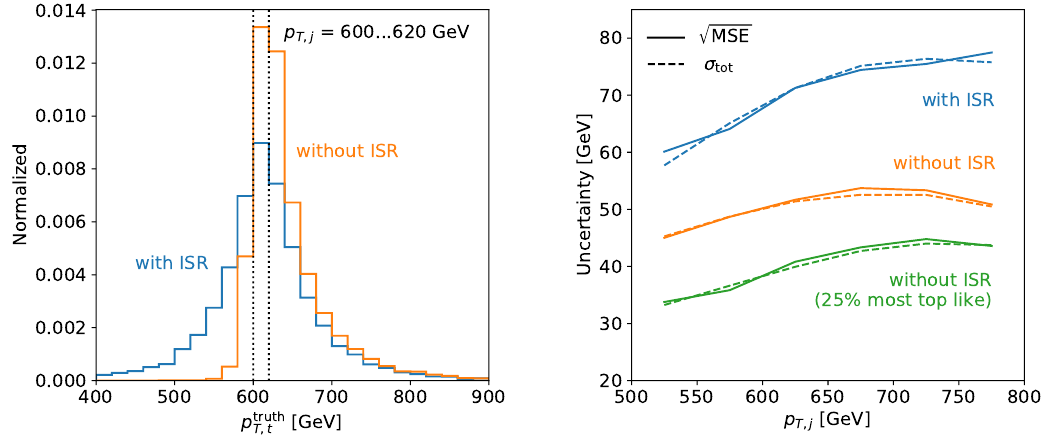
= 600 ... 620 GeV, for jets with p T , j T , t as the network output (dashed). stoch